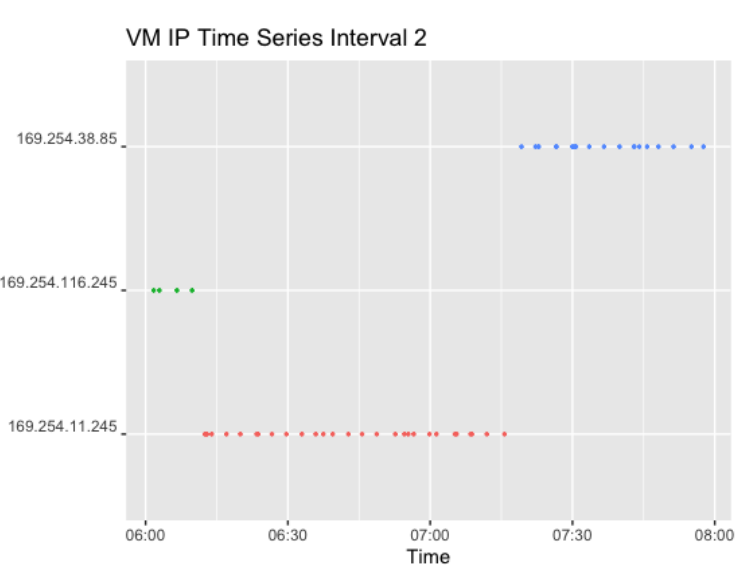
Figure 10. Interval 1 IP Distribution.